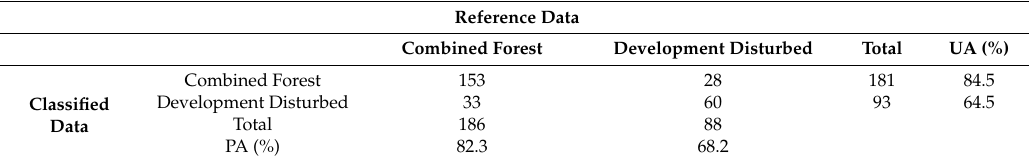
Table 2. Error matrix from the D 3 - based CART model.